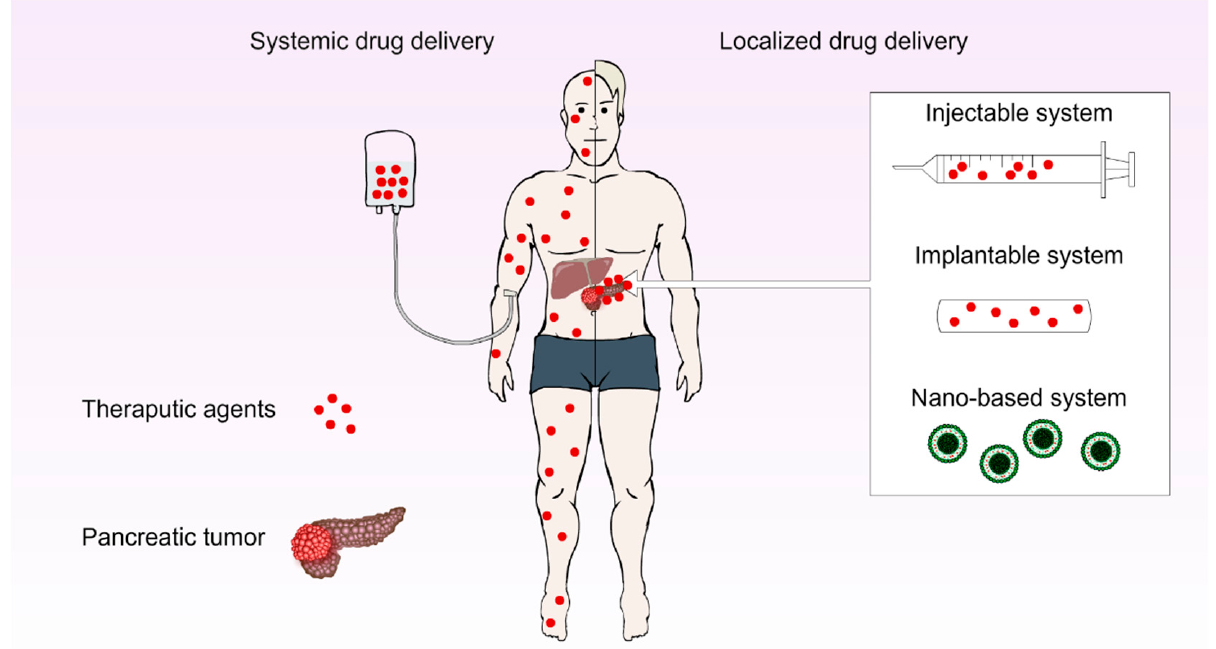
Figure 2. Illustration of localised vs. systemic therapy for the treatment of PC. Systemically injectables are designed to kill cancer cells that have migrated outside of the pancreas to organs elsewhere in the body. Localised therapy, including injectable, implantable, and micro/nano-based formulations, affect a specific area of the pancreas to control a wide margin of tumours. Image adapted from Aquid et al. [77] .